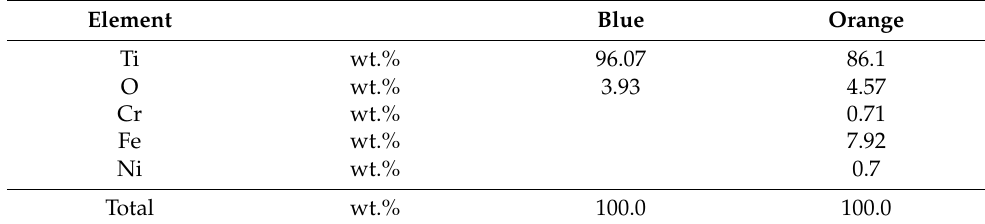
Table 1. EDXS analyses’ results in wt.% (Figure